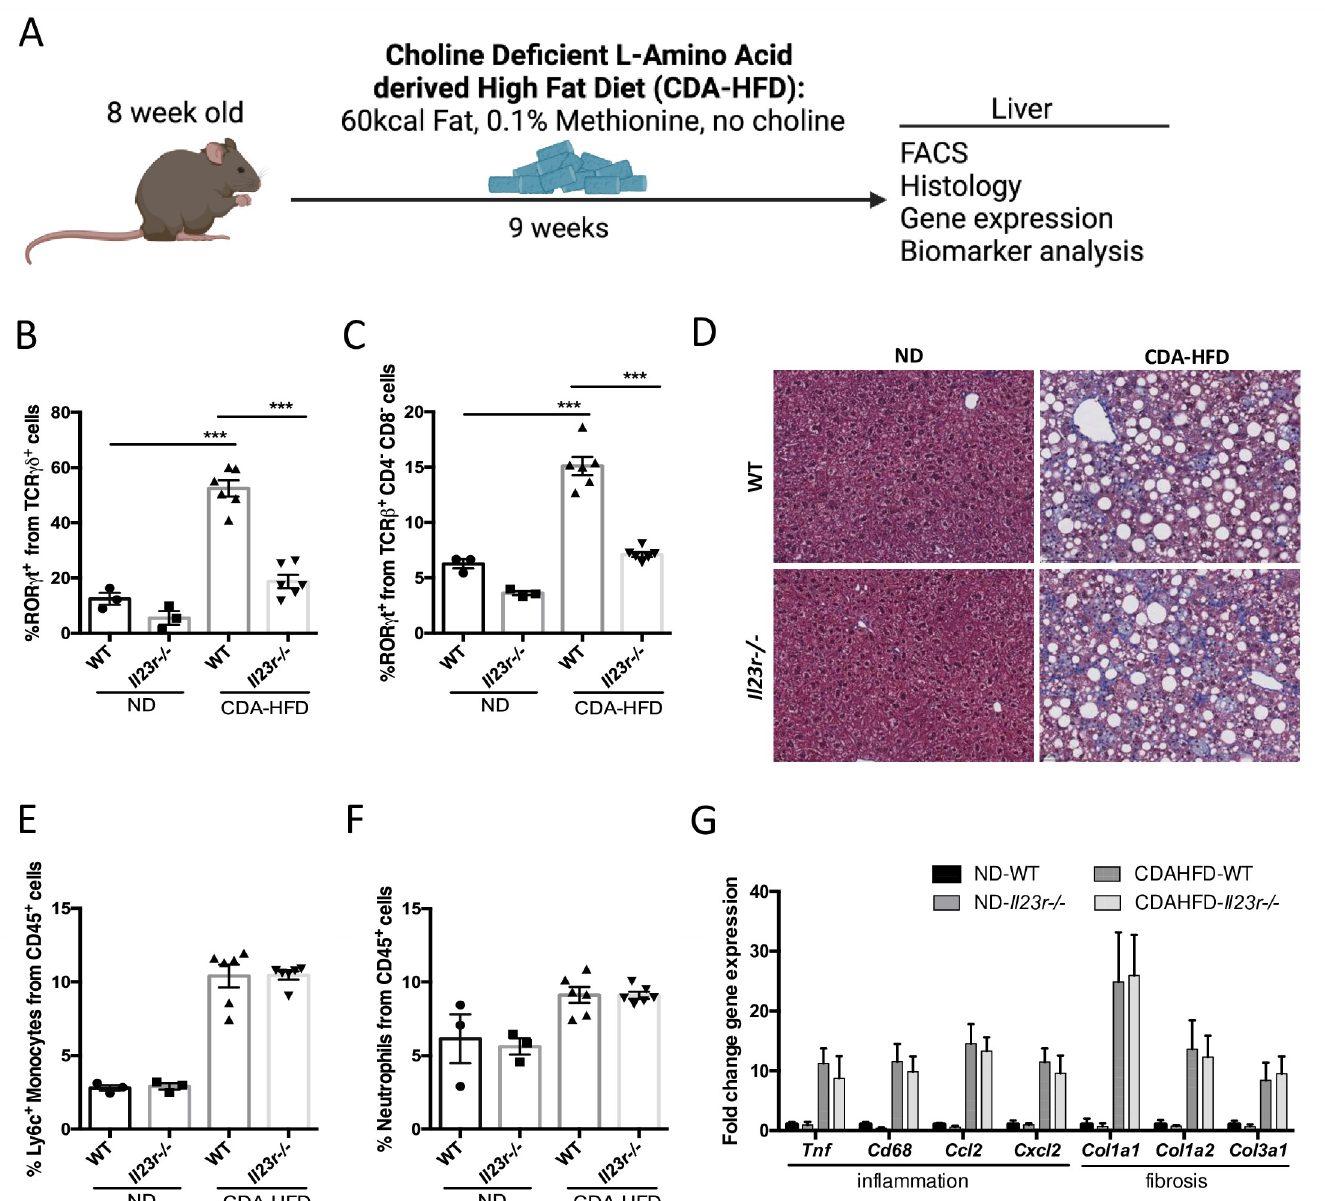
Fig 6. IL-23 signaling does not contribute to liver inflammation and fibrosis in the CDA-HFD NASH model. WT and Il23r -/- mice were fed CDA-HFD for 9 weeks, followed by liver analysis (A). Percent quantification of hepatic ROR γ t in γδ T Cells (B) and MAITs (C). Trichrome staining images and quantification of Inflammation (E) and Trichrome Collagen content (F). Liver mRNA expression of Tnf , Cd68 , Ccl2 , Cxcl2 , Col1a1 , Col1a2 , and Col3a1 (G). Groups: ND WT n = 3, ND Il23r -/- n = 3, CDA-HFD WT n = 6, CDA-HFD Il23r -/- n = 6. Data represents mean ± S.D. ��� p < 0.0005, one-way